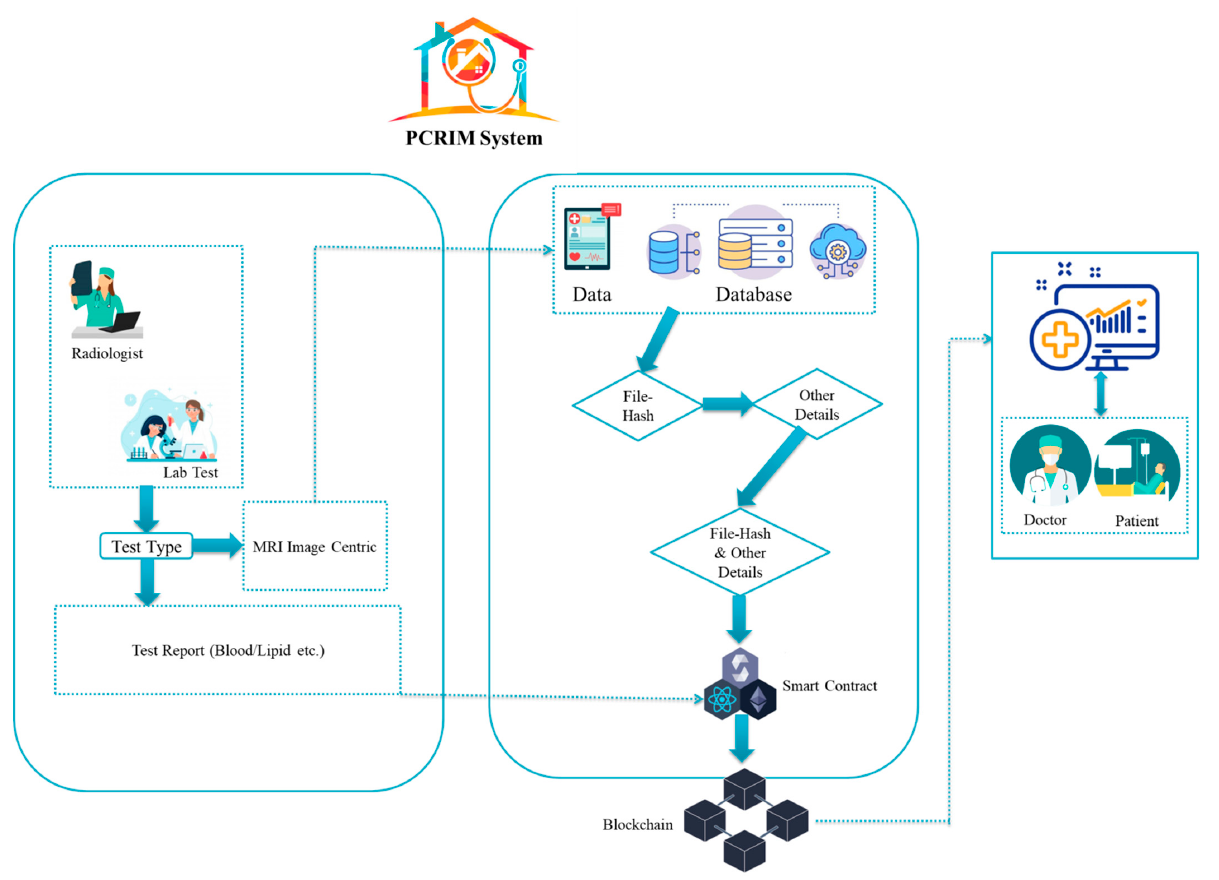
Figure 4. An illustration of the detailed solution.